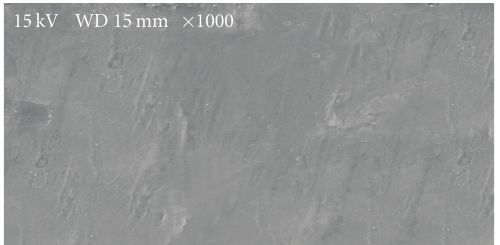
Figure 11: SEM Photograph of mild steel immersed in 1N HCl solution containing an optimum conc. (8% v/v) of Aegle marmelos .